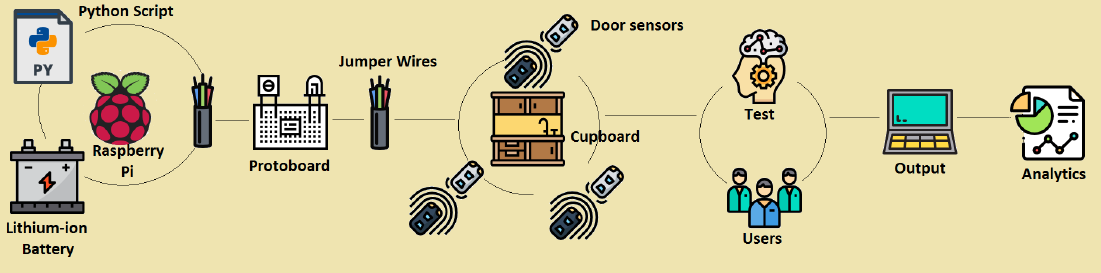
Figure 1. Overview of the smart cupboard and the experiments.